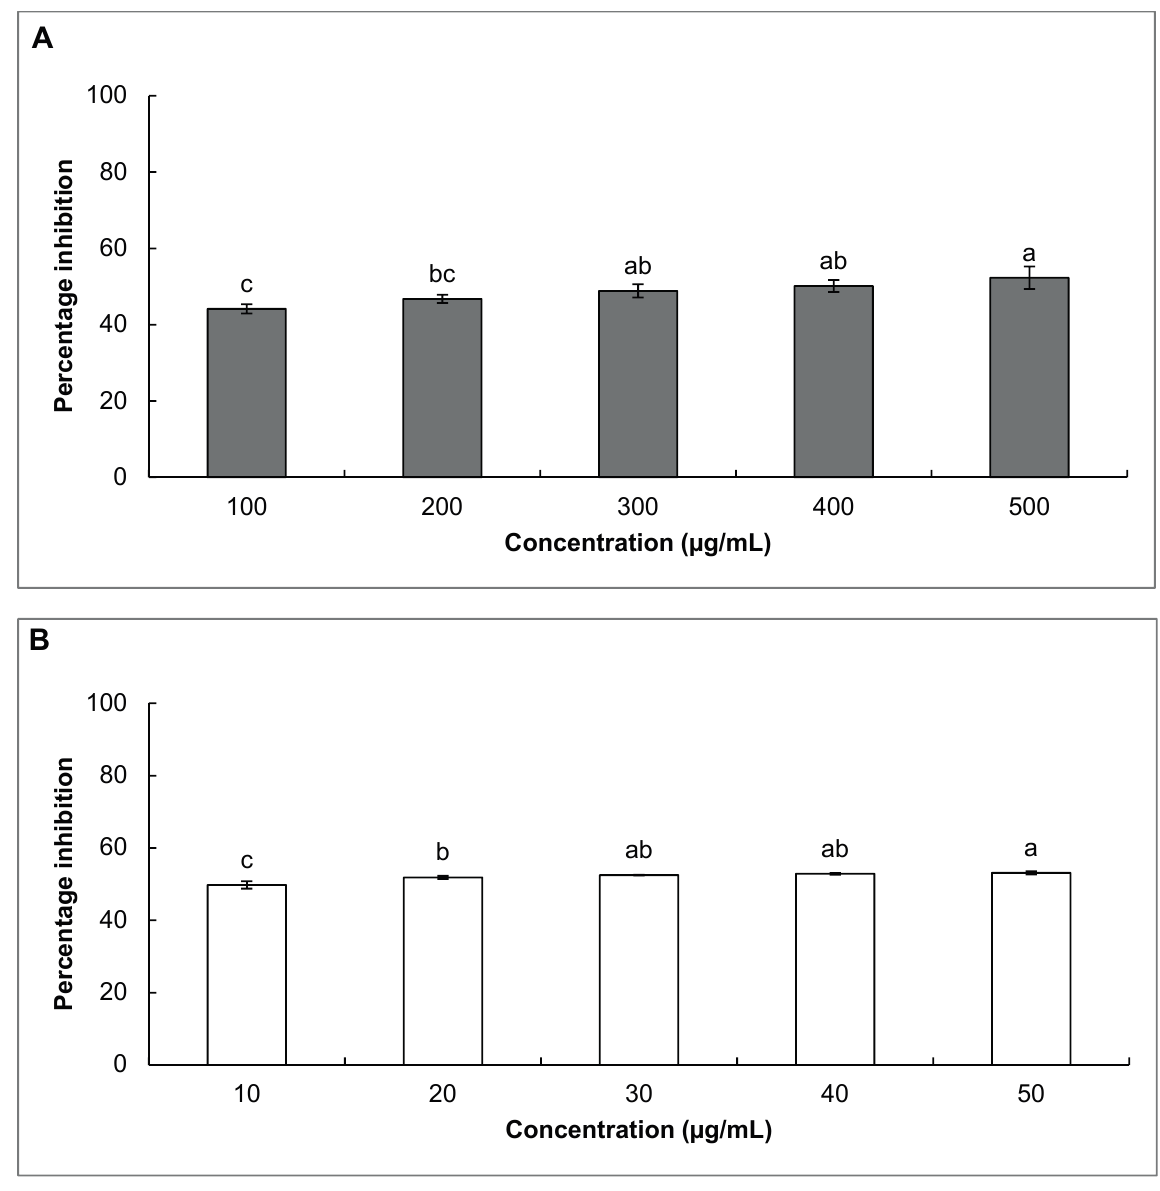
Figure 3. Inhibition of lipid peroxidation by ( A ) Japanese red pine sawdust bio-oil (SBO) and ( B ) gallic acid as a reference. Columns with different superscript letters indicate a significant difference at p <